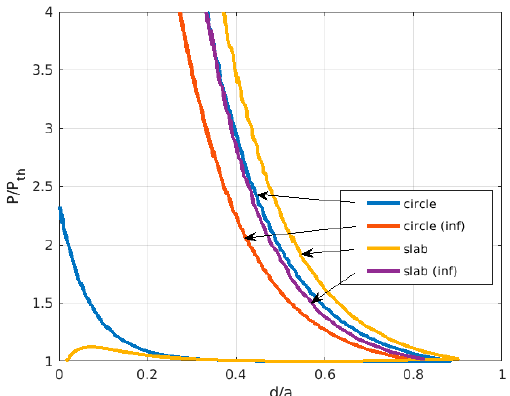
Figure 8. Stability boundaries in the plane of P / P th versus d / a for coupled circular cylindrical guides with v = 3.740.